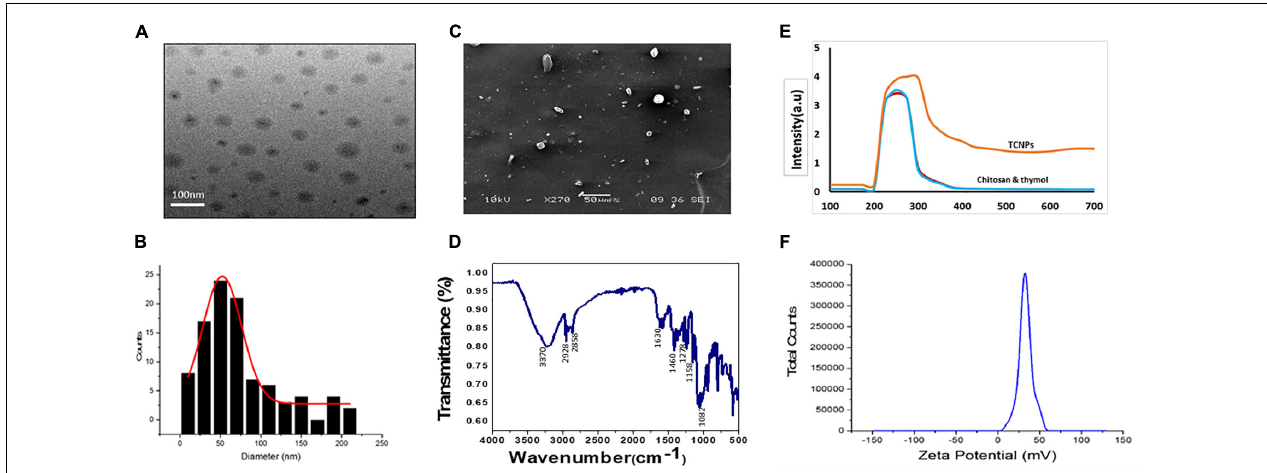
FIGURE 1 | Characterization of thymol loaded chitosan nanoparticles. (TCNPs). (A) TEM analysis (B) Histogram for particle size distribution by DLS (C) SEM analysis (D) FTIR spectrum for thymol loaded chitosan nanoparticles. (E) UV—visible absorption spectrum of the nanoparticles (F) Zetapotential for the nanoparticles.